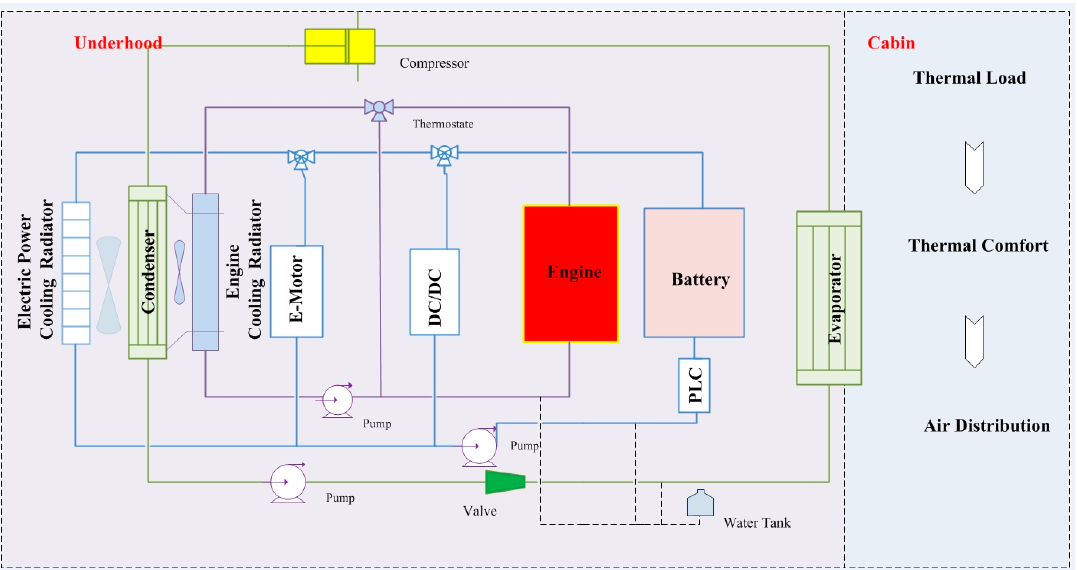
Figure 4. Typical thermal management schematics diagram of hybrid electric vehicle (HEV).